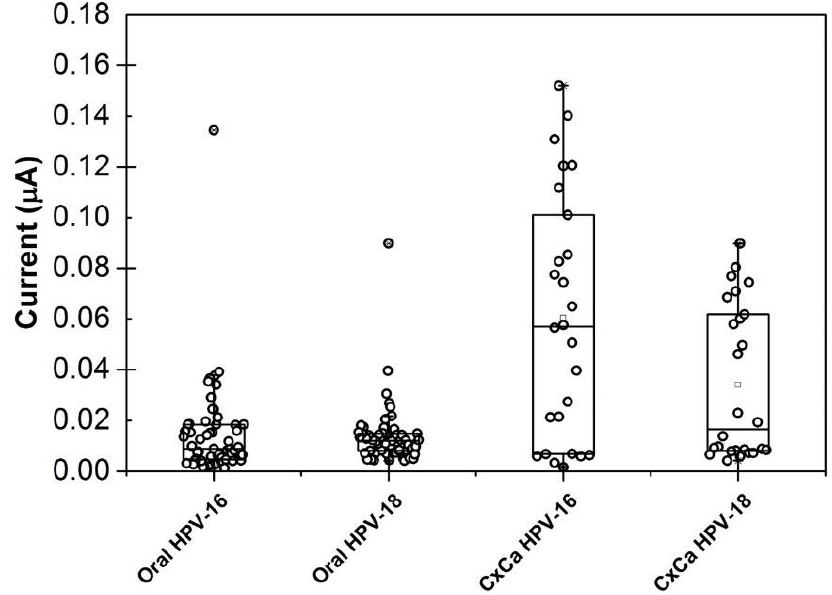
Figure 4. Box-and-whisker plot showing the mean current values for the electrochemical detection of HPV-16 and HPV-18 in 55 oral and 25 cervical cancer (CxCA) samples. HPV-16 was detected in two OSCC samples, while HPV-18 was detected in only one OSCC sample. For cervical cancer samples, HPV-16 was detected in 16 samples, while HPV-18 was detected in 11 samples. For HPV-16 detection, the positive controls were plasmid DNA with HPV-16 and SiHa cells, while negative controls were white blood cells (WBC) and HeLa cells. For HPV-18 detection, the positive controls were plasmid DNA with HPV-18 and HeLa cells, while negative controls were white blood cells (WBC) and SiHa cells. The circles represent the mean current responses of five independent replicates. The boxes represent the interquartile range. The line across the box represents the median. Whiskers represent the maximum and minimum values of each set. Table 3 . Comparison of HPV-16 and HPV-18 detection in clinical samples using nested PCR/gel electrophoresis and electrochemical biosensor. + indicates a positive result, − indicates a negative result.